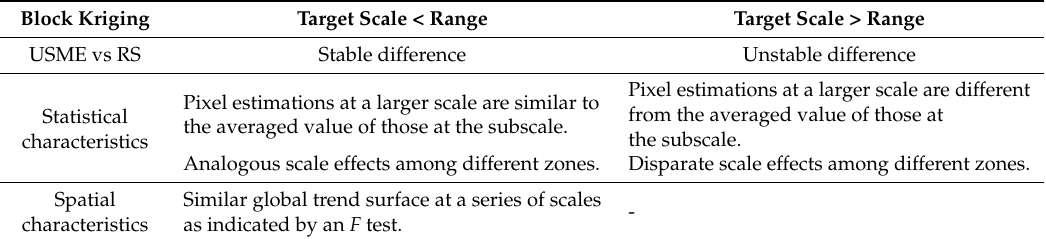
Table 7. Comparison of scale effects among scale series according to the magnitude of the target scale and the range based on the upscaled soil moisture estimations (USME) of SoilNET.